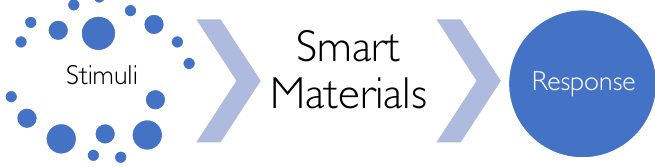
Figure 1. Schematic representation of smart materials’ behaviour.